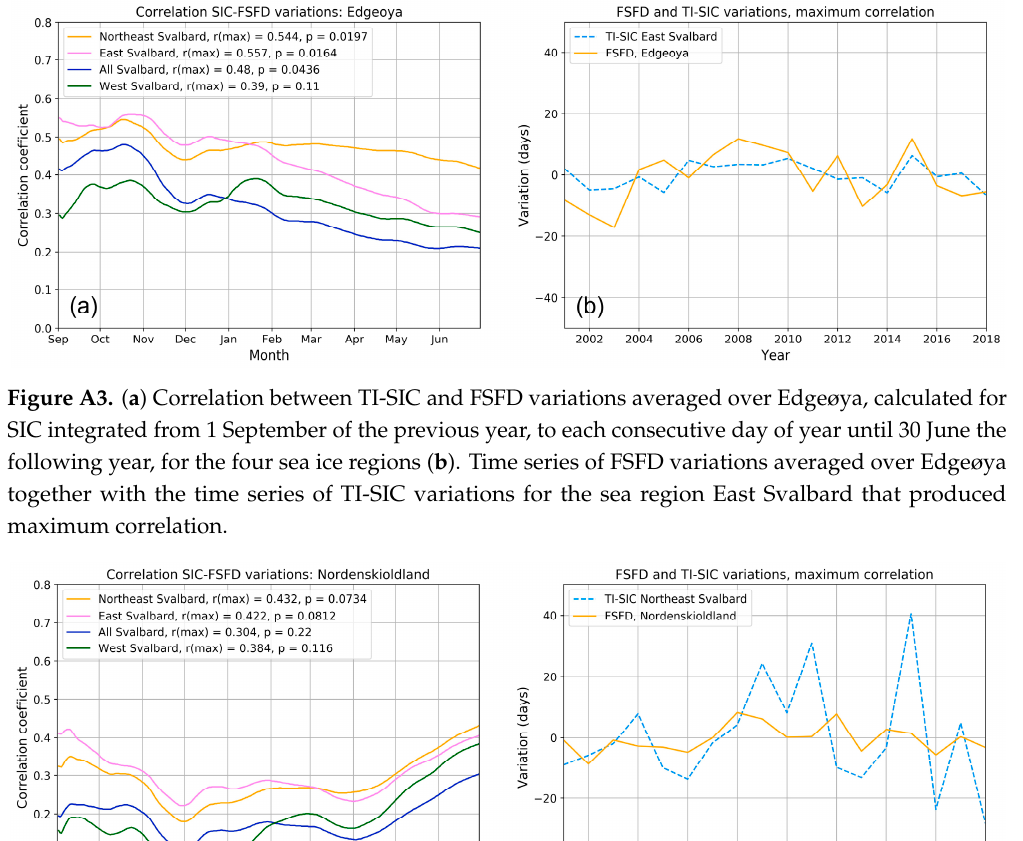
Figure A5. As for Figure A3 but for FSFD variations averaged over the whole of Svalbard and TI-SIC for Northeast Svalbard.